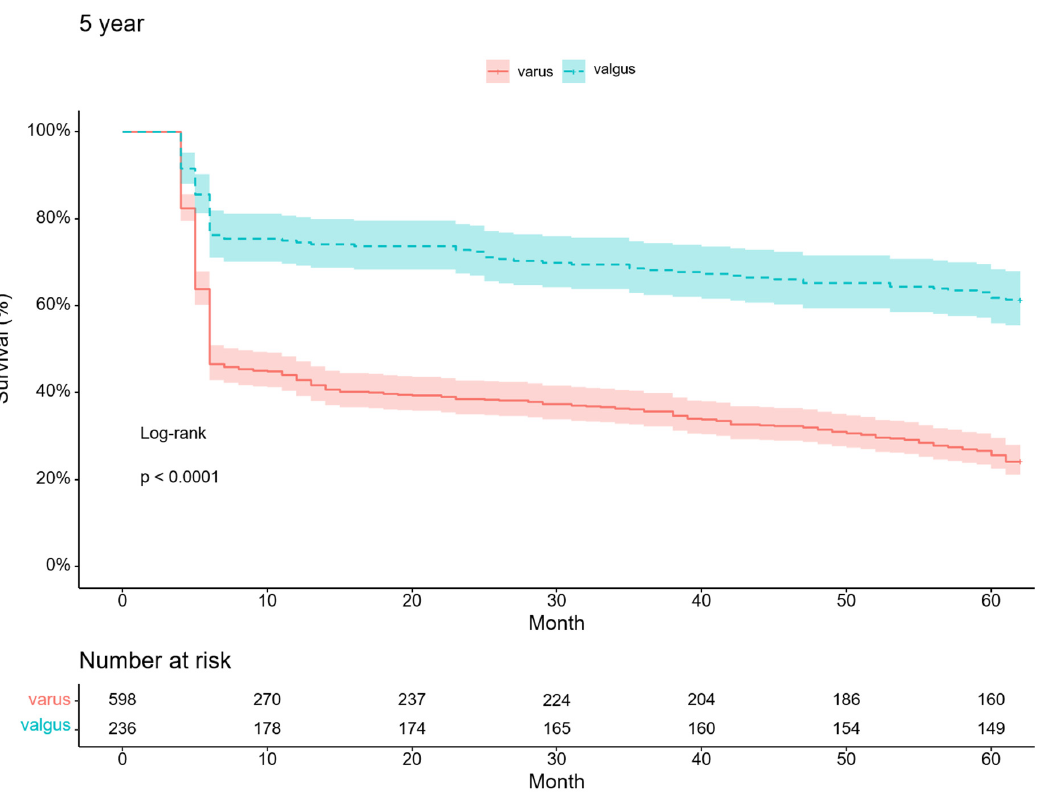
Figure 3. Five-year Kaplan–Meier survivorship curve for varus and valgus arthritic knees.